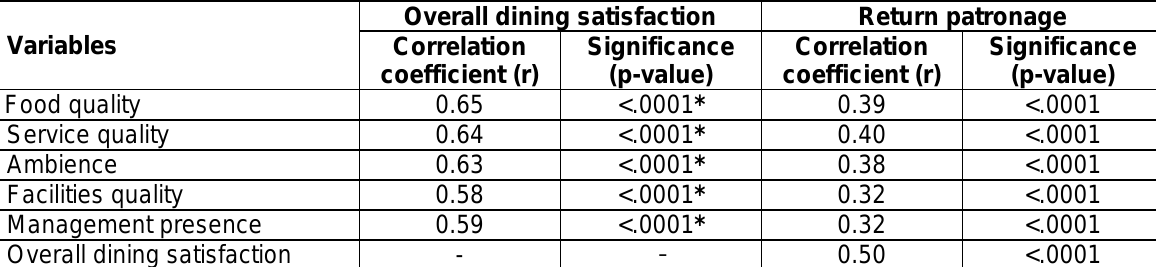
Table 2: Correlation results of overall dining satisfaction and return patronage Overall dining satisfaction Return patronage Variables Correlation